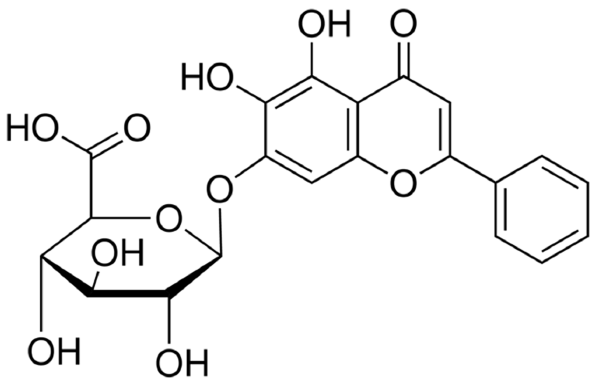
Figure 1. Chemical Structure of baicalin (BC).